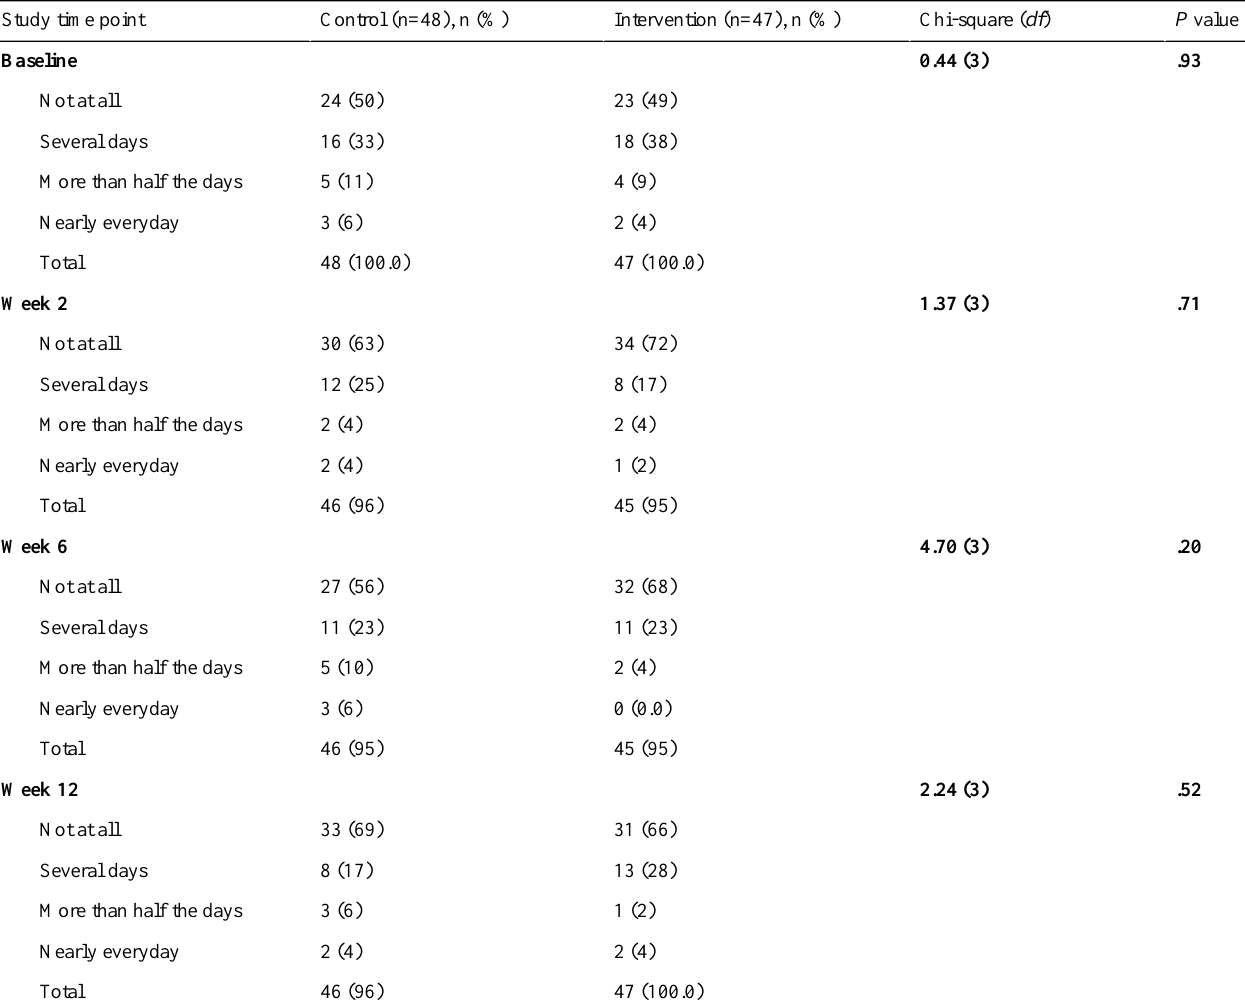
Table 7. Mean and median scores on the Patient-Health Questionnaire -9, Question 9